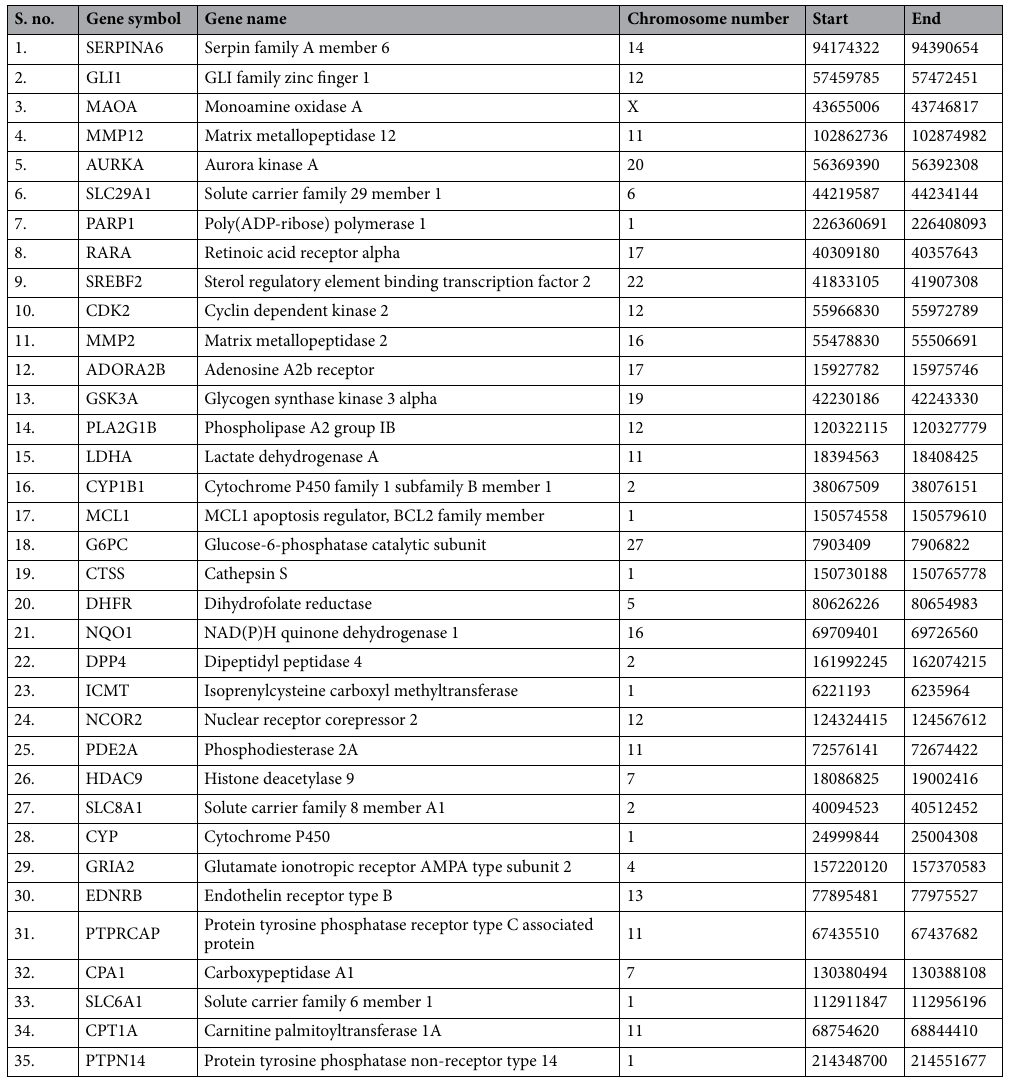
Table 3. Molecular attributes of the identified thirty-five human immune responsive